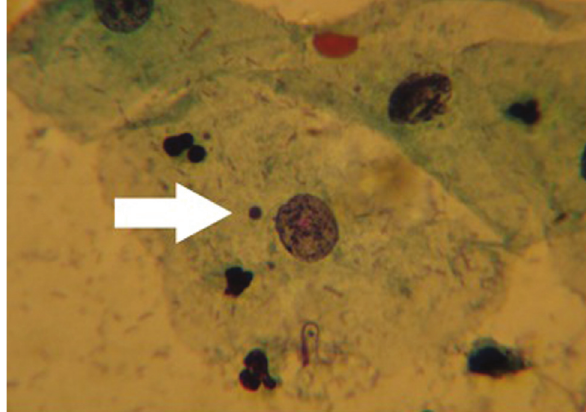
Figure 1 - Cervical smear showing the morphology of a squamous cell with micronuclei (arrow). Magnification: